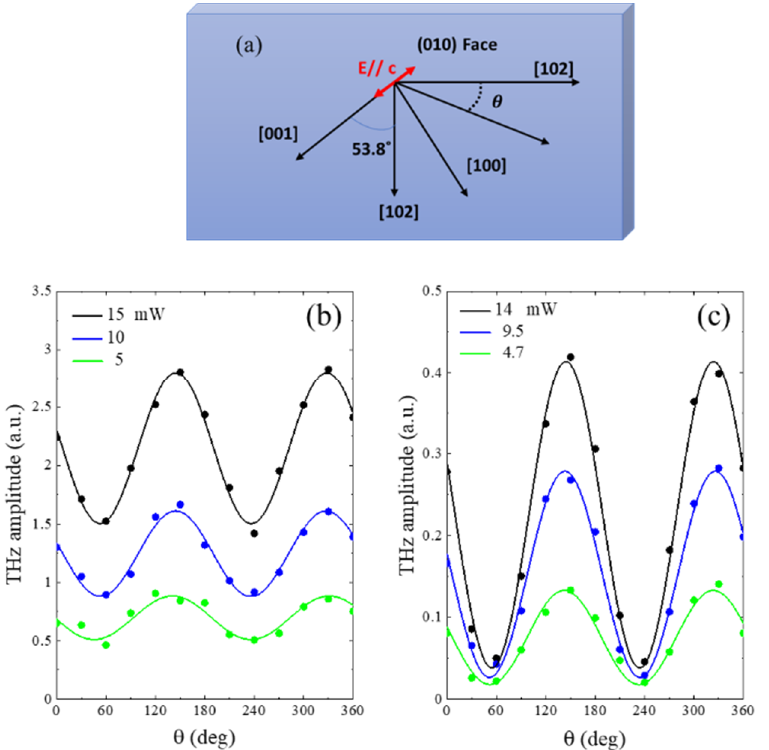
Figure 6. Pump polarization angle dependence of the THz radiation amplitude for Fe-doped (010) at various pump powers and wavelengths. ( a ) illustrates the schematic configuration of the measurements. The angle starts from the parallel to the [102] direction. ( b ) and ( c ) are measured at a wavelength of 245 nm and 260 nm, respectively.